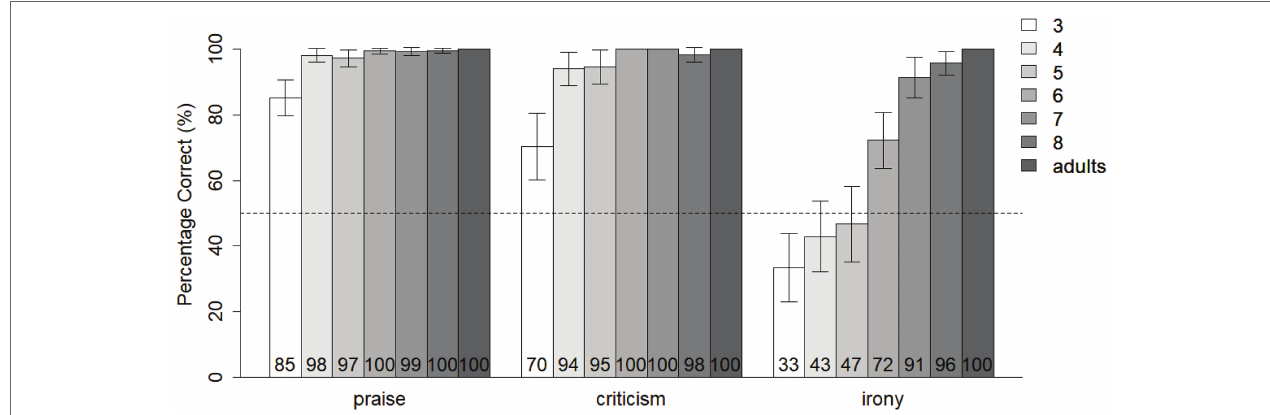
FIGURE 2 | Percentage of correct picture choice for different utterance types (literal praise, literal criticism, and irony) and age groups (3–8, adults). Error bars represent 95% confidence intervals. Dotted line indicates chance